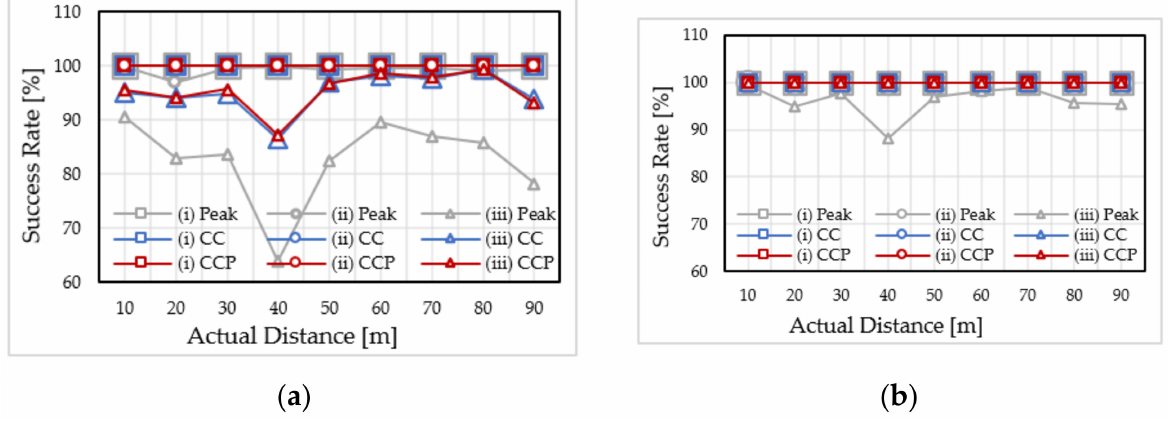
Figure 14. Measurement success rate applied with the different number of transmitted pulses/frame: